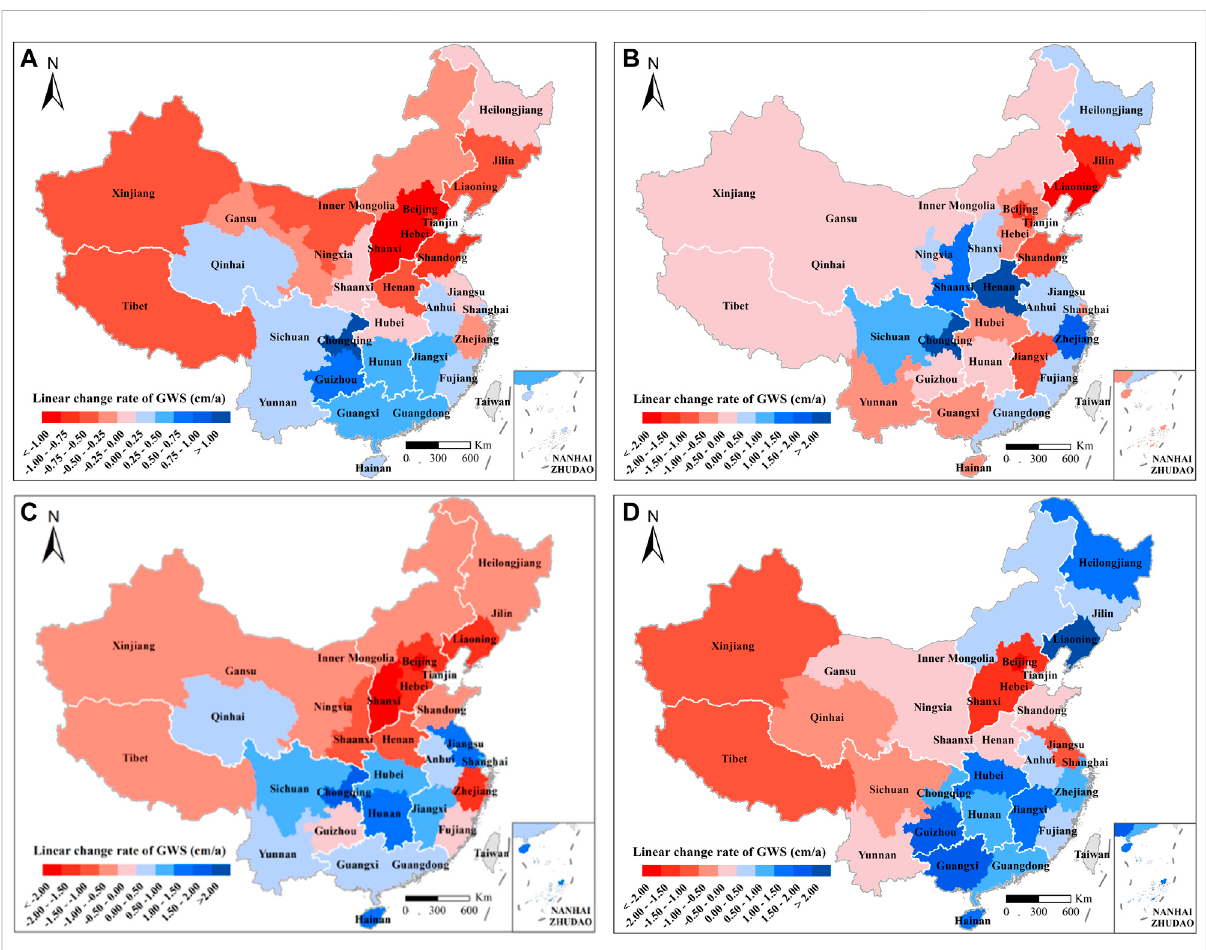
FIGURE 7 Changes in the linear rates of the GWS at the provincial level in China (cm/a) for (A) 2002 – 2016, (B) 2002 – 2006, (C) 2007 – 2011, and (D) 2012 –